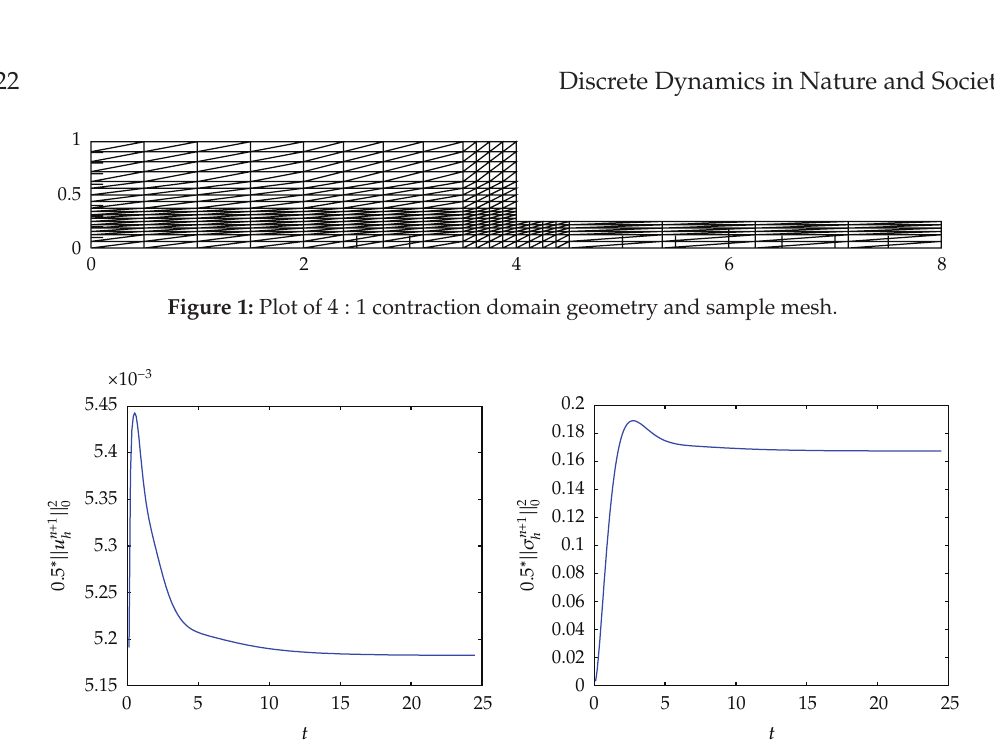
Figure 2: Evolution of (cid:6) u n (cid:11) 1